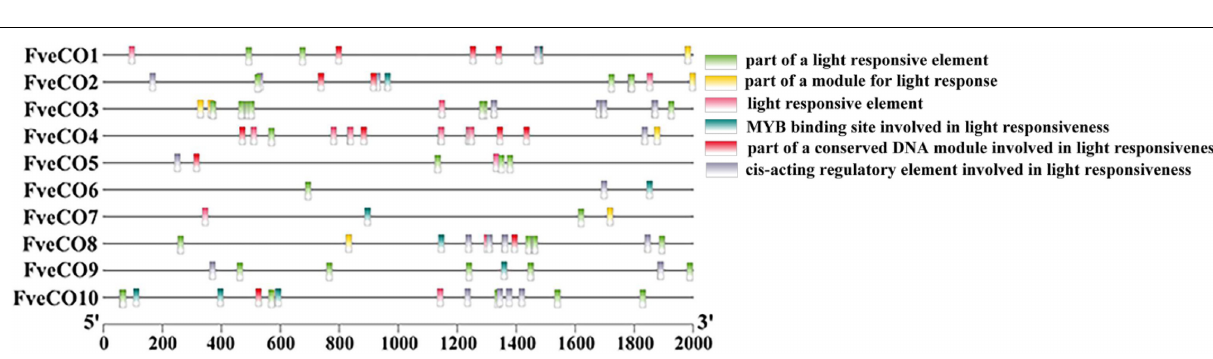
FIGURE 5 | Microsynteny of CONSTANS-like (COL) regions across Fragaria vesca , M × domestica , O. sativa, and A. thaliana . The F. vesca , M × domestica , O. sativa, and A. thaliana chromosomes are shown in different colors. The number on each chromosome box indicates the number of chromosomes. Blue lines represent the syntenic relationships between AtCOLs , MdCOs , OsCOLs, and FveCOs regions. Light gray lines represent the syntenic relationships between genome wide of Arabidopsis , woodland strawberry, apple, and rice.